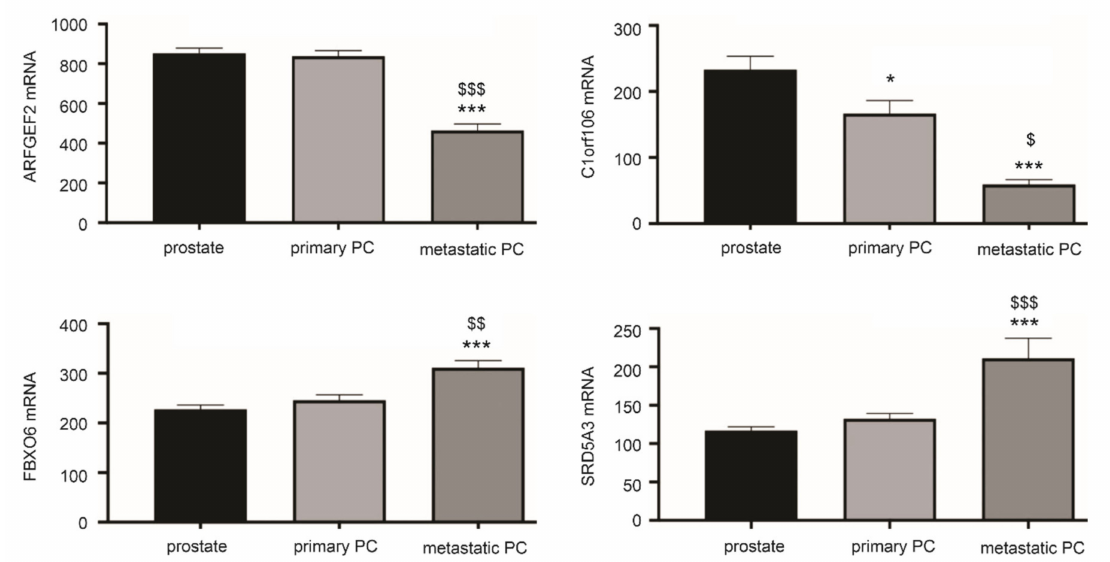
Figure 5. Differential expression of LE genes following PC progression. The curated GEO GDS2546 dataset was used for these analyses. Normal prostate tissue (prostate) n = 67, primary PCs ( n = 66), and mPCs ( n = 25) [56,57]. * p < 0.05, *** p < 0.001 in comparison to normal prostate tissues; $ p < 0.05, $$ p < 0.01, $$$ p < 0.001 in comparison to primary PCs. One-way ANOVA was performed, followed by post-hoc analysis using the Tukey’s multiple comparisons